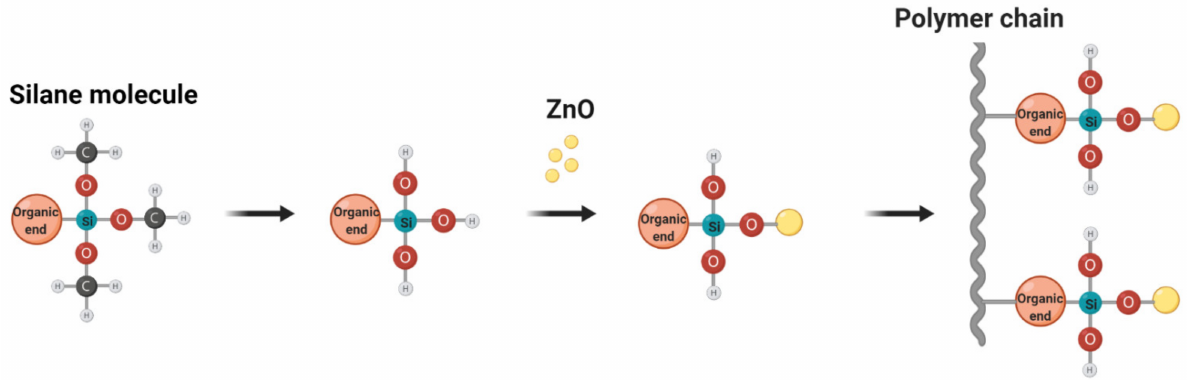
Figure 1. Schematic diagram of ZnO modification process with